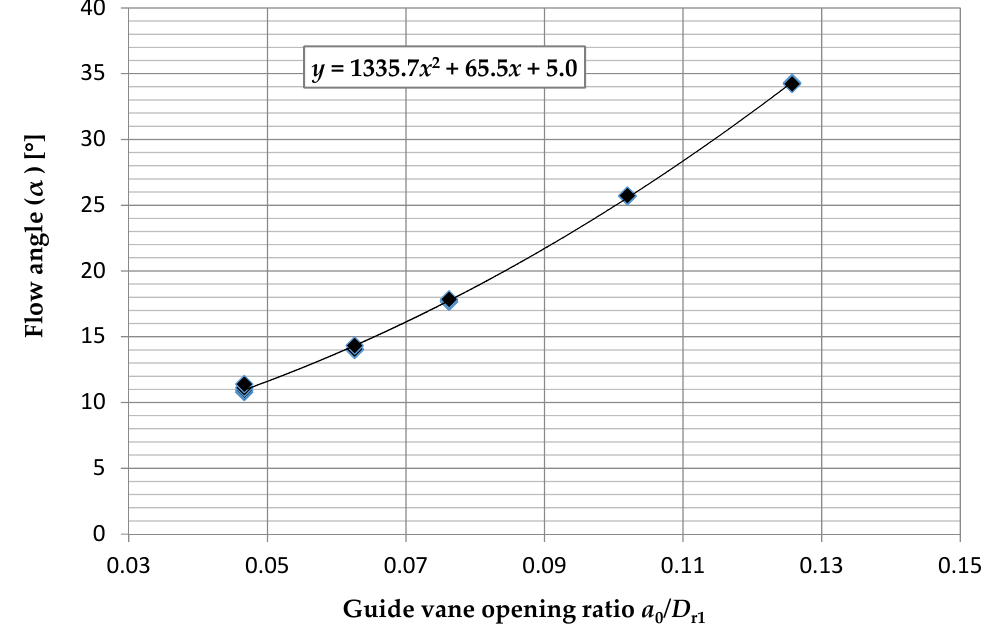
Figure 3. Relation of flow angle and guide vane opening ratio.